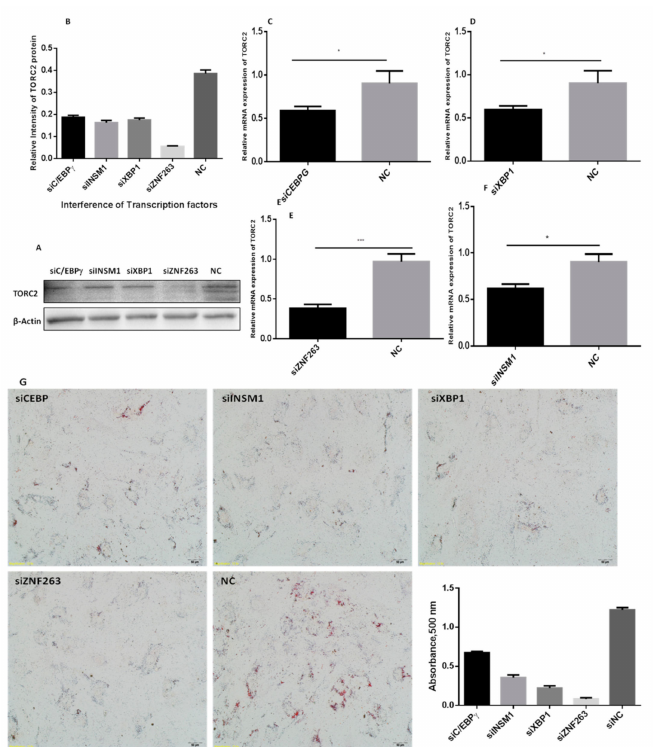
Figure 8. Expression level of the TORC2 gene and cell phenotypes of adipocytes transfected with siRNAs of selected transcription factors. ( A , B ) Protein level of TORC2 in preadipocytes transfected with siC / EBP γ , siXBP1, siZNF263, siINSM1 and NC. ( C – F ) Shows mRNA expression level of TORC2 gene in preadipocytes transfected with siC / EBP γ , siXBP1, siZNF263, siINSM1 and NC. GAPDH was used as the housekeeping gene. The values represent mean ± SEM ( n = 3). * p < 0.05 and *** p < 0.01. ( G ) Shows the cell phenotypes of adipocytes transfected with siC / EBP γ , siXBP1, siZNF263, siINSM1 and NC stained with Oil red O